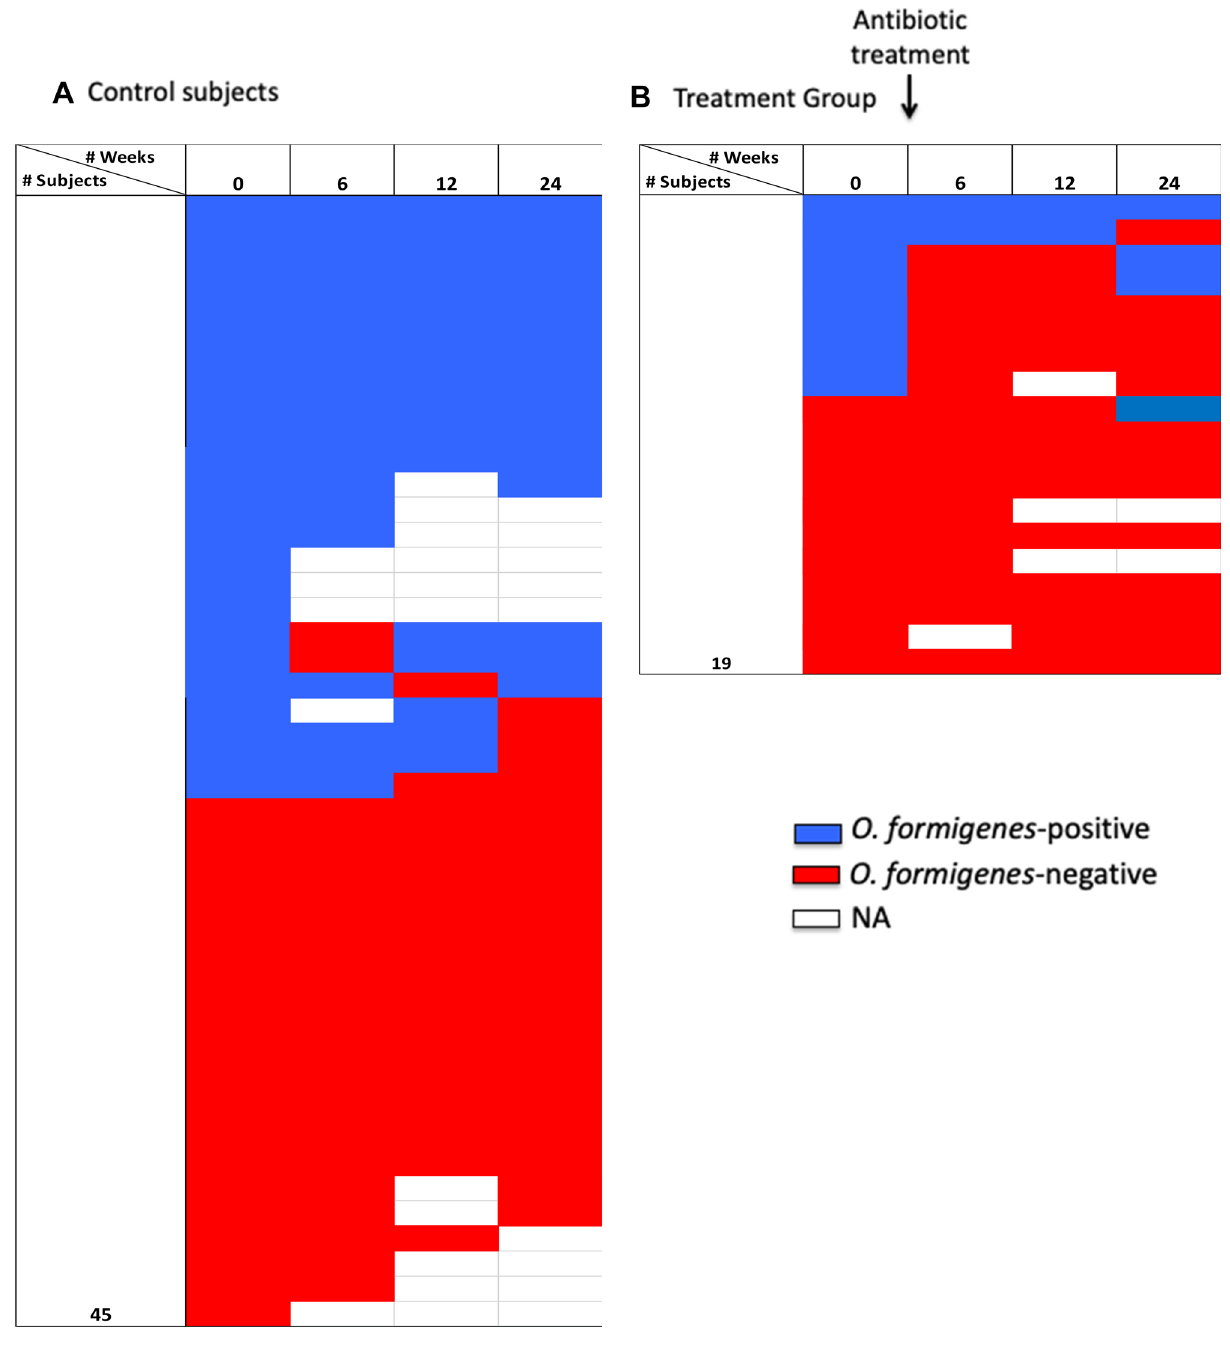
Figure 2. O. formigenes colonization status in 45 control subjects and 19 antibiotic-treated subjects over the study period. O. formigenes -positive samples are shown in blue, negative in red, and missing in white. Panel ( A ) Untreated control subjects. Panel ( B ) Antibiotic-treated subjects. Figure created by Excel software version